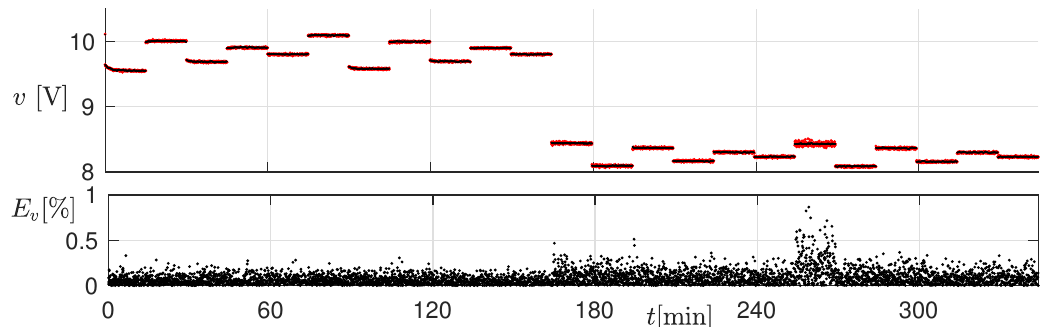
Figure 13. Top panel: measured (black) and estimated (red) output voltage at electrical steady-state for all the considered operating conditions. Bottom panel: relative percent error on the output